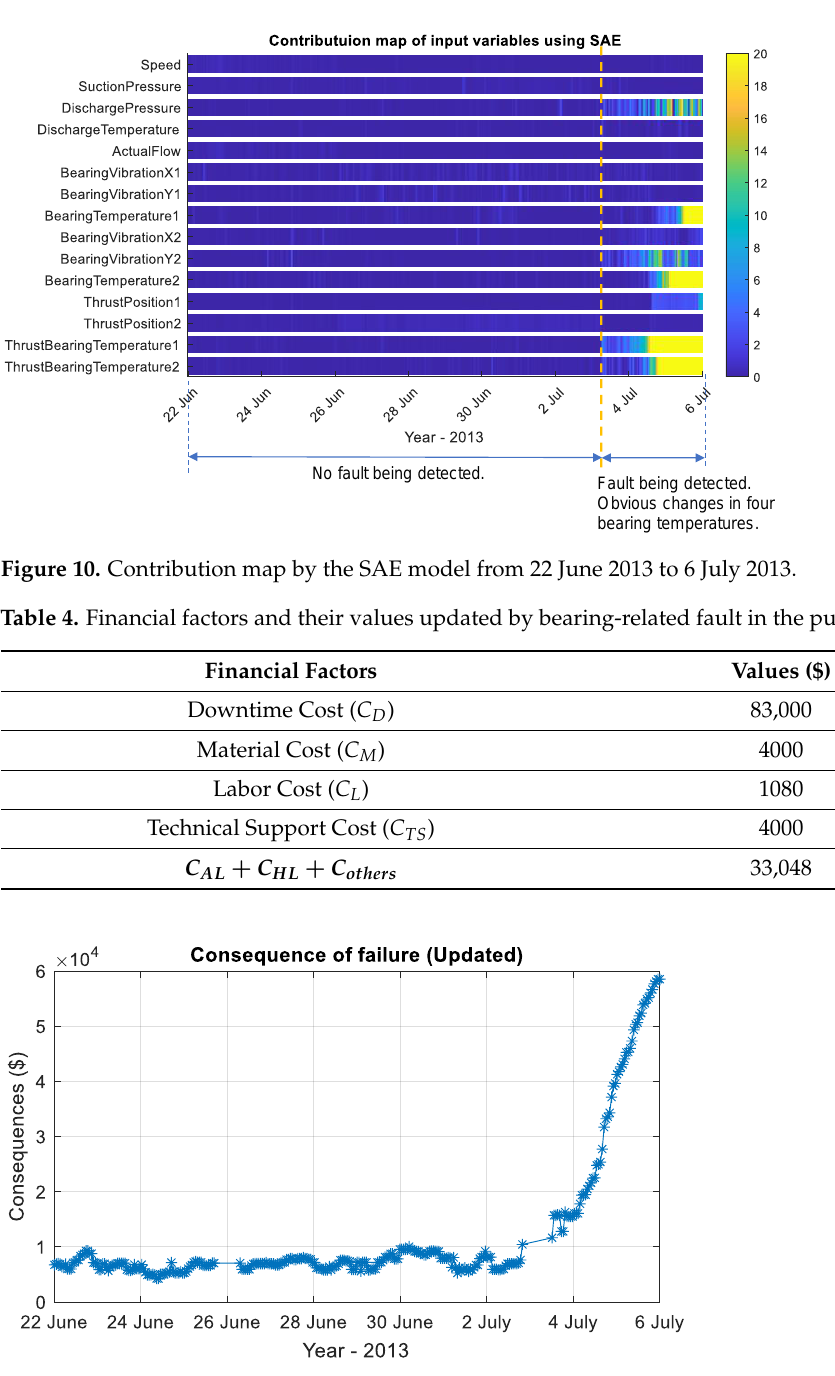
Figure 11. Consequence of a fault occurring in the pump system updated by bearing-related fault.